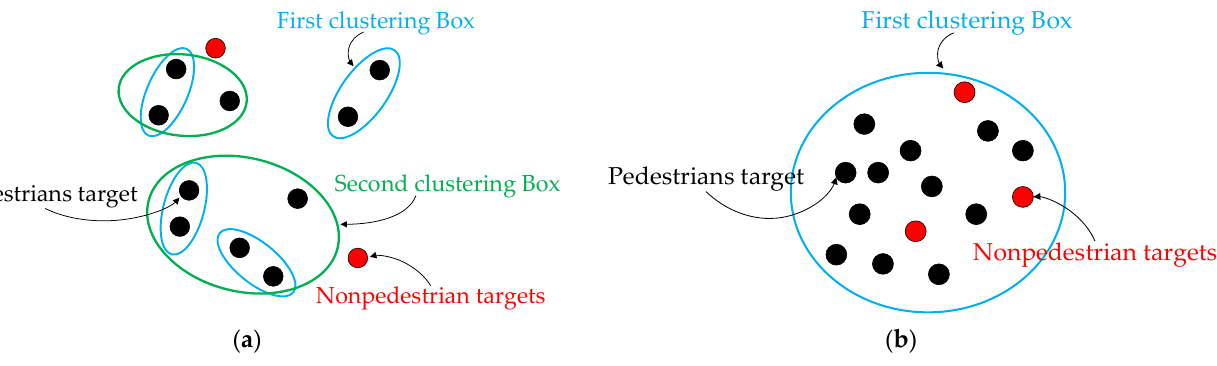
Figure 8. Detection results of crowd target. ( a ) Euclidean cluster in Condition 1; ( b ) Euclidean cluster in Condition 2.